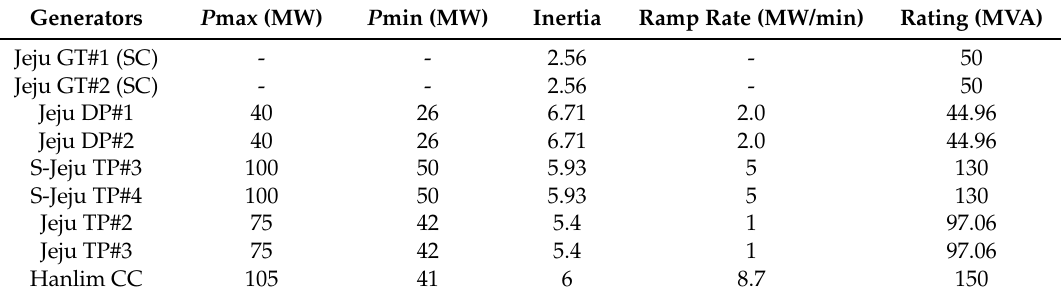
Table 1. Generators in Jeju Island operation.